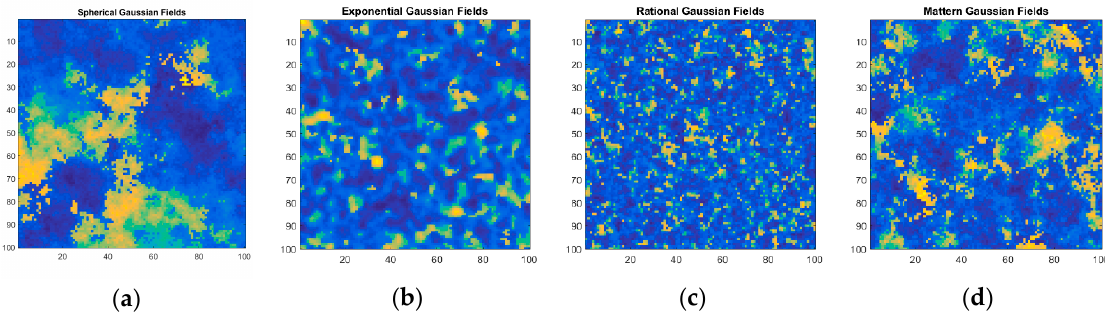
Figure 4. An example of the fractional abundances that were generated using: ( a ) Spherical Gaussian fields; ( b ) Exponential Gaussian fields; ( c ) Rational Gaussian fields; and ( d ) Mattern Gaussian fields functions.